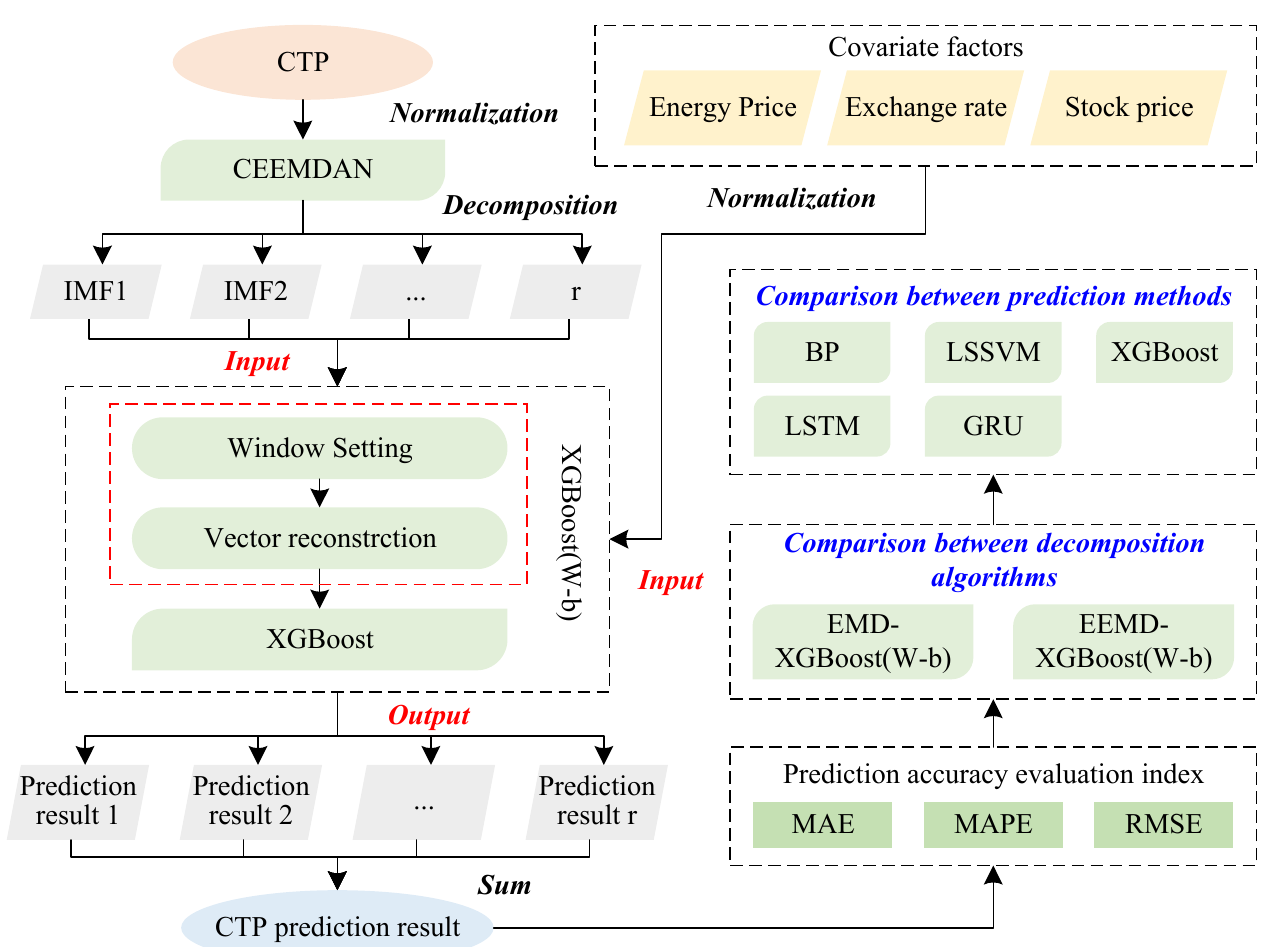
Figure 2. The framework of the CTP forecasting based on CEEMDAN and XGBoost(W-b).